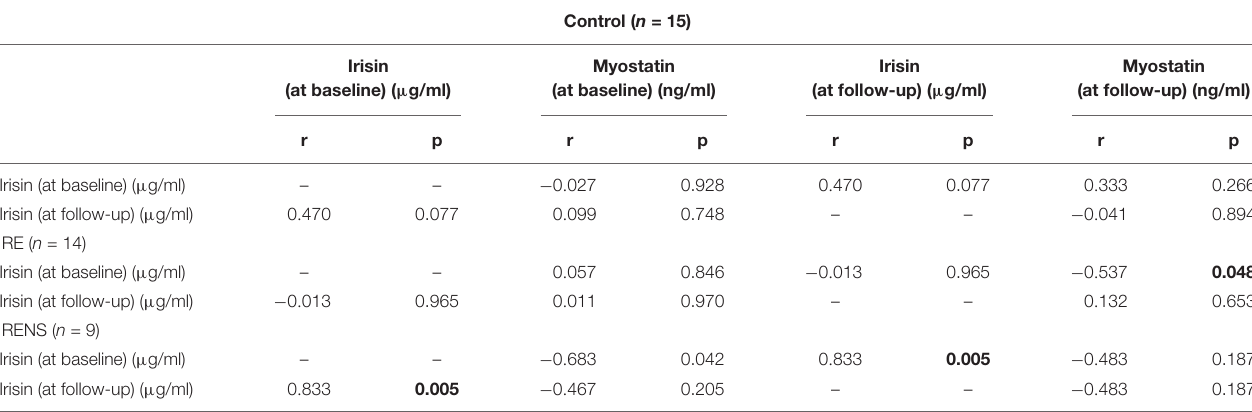
TABLE 4 | Bivariate correlations between Irisin and